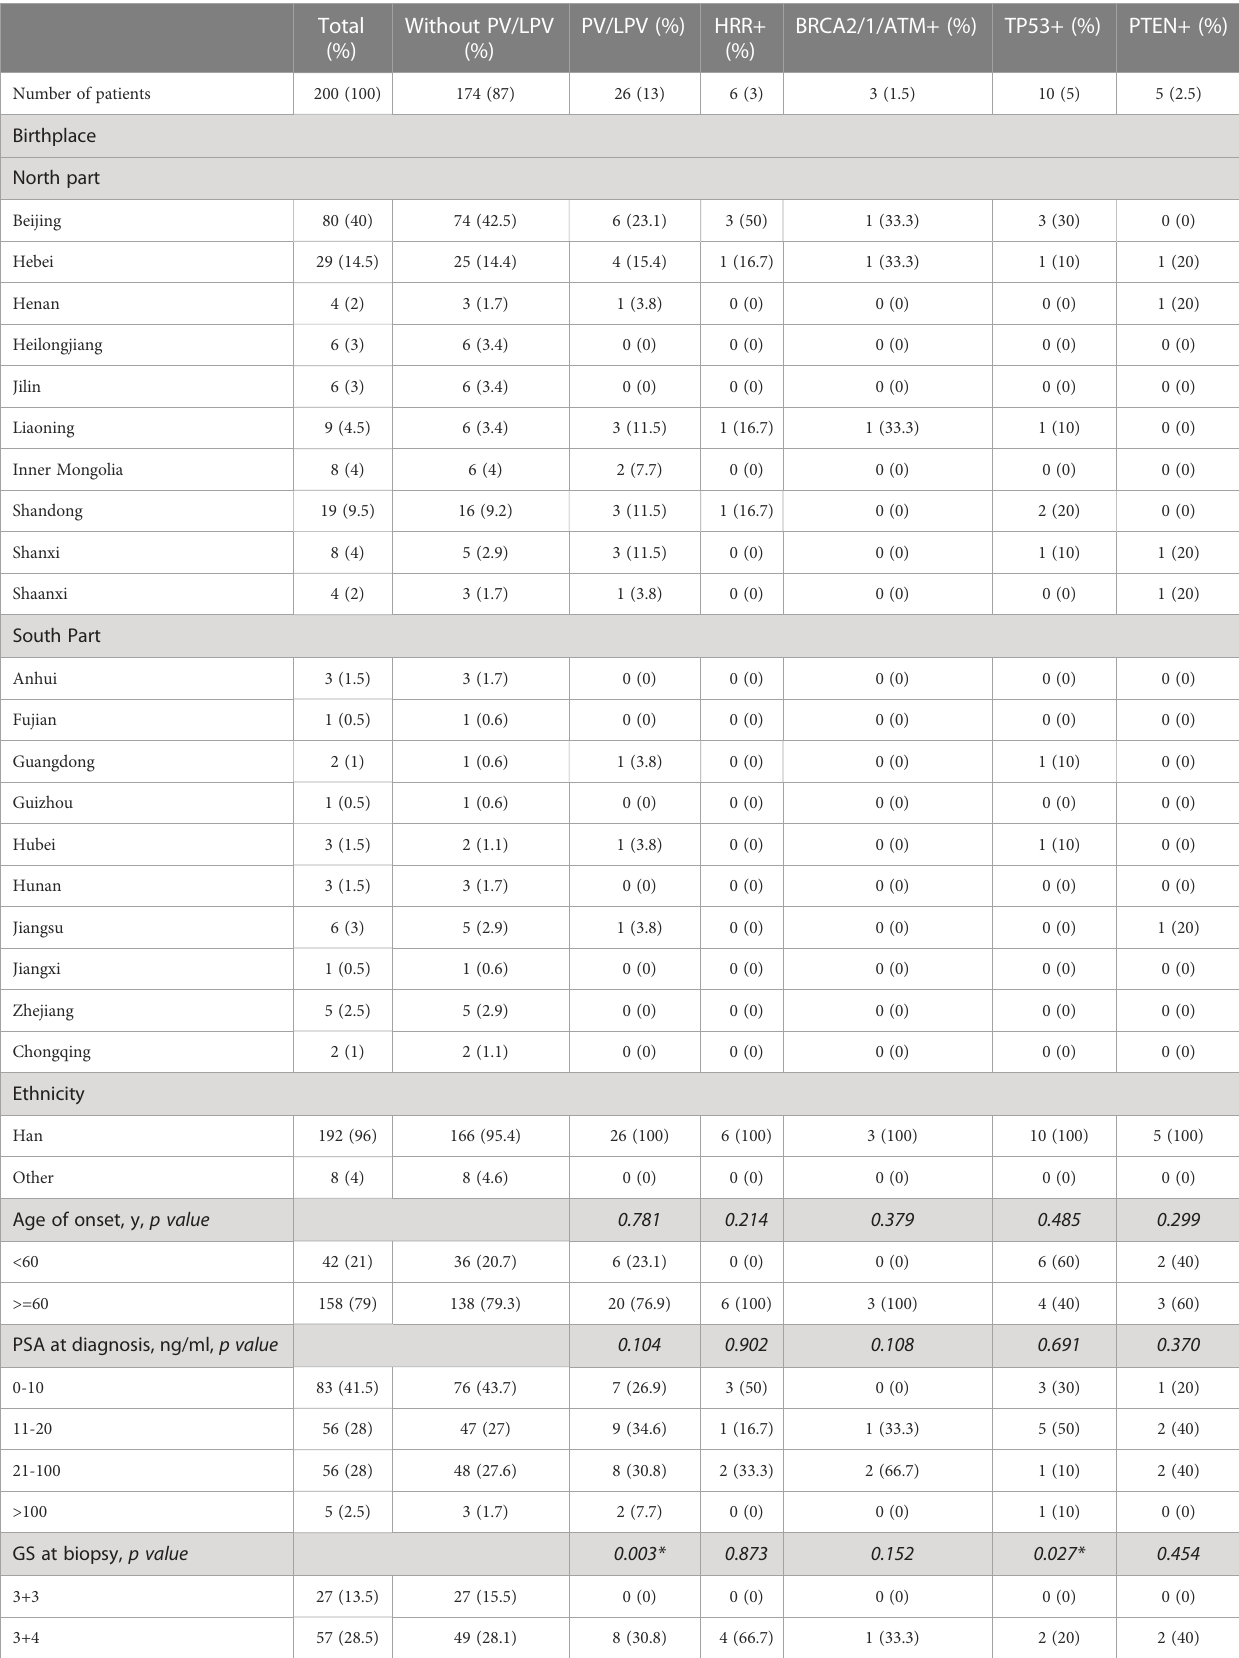
TABLE 1 Clinical characteristics of somatic testing at